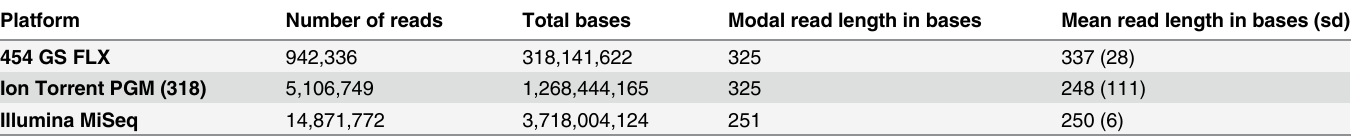
Table 1. Platform comparison — run details.